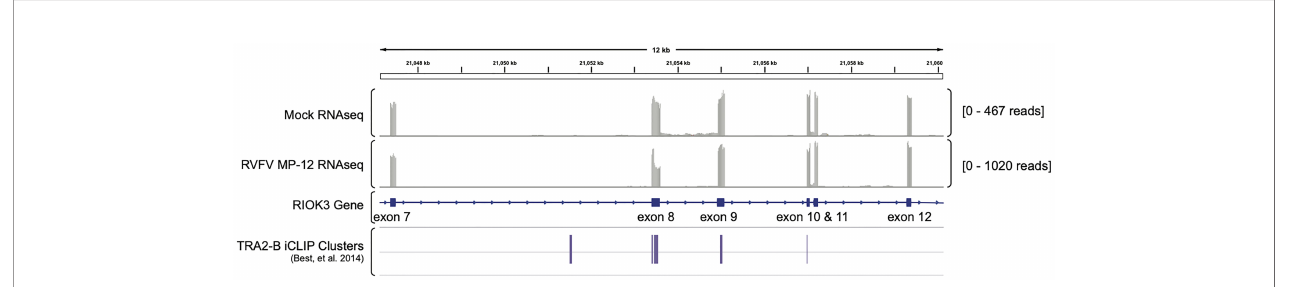
FIGURE 4 | TRA2- b interacts with RIOK3 mRNA. RNAseq-derived Integrated Genomics Viewer (IGV) tracks of mRNA expression in mock- vs. RVFV MP-12- infected HEK293 cells highlighting RIOK3 (data are from Havranek et al., 2019). TRA2- b -bound iCLIP cluster reads from Best, et al. (2014; GEO accession number GSE59335) are aligned